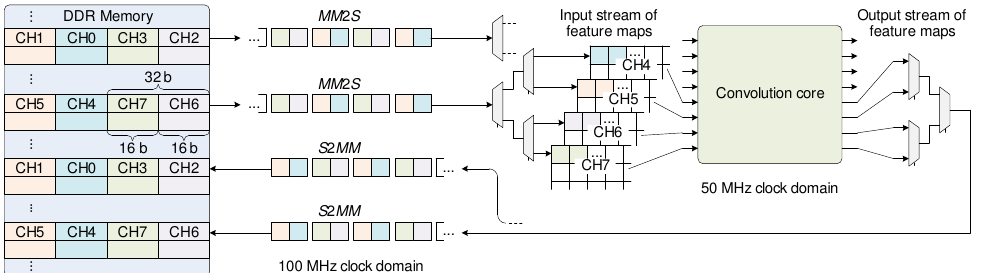
Figure 7. The stream of the input and output feature maps to/from the convolutional core on the PL.